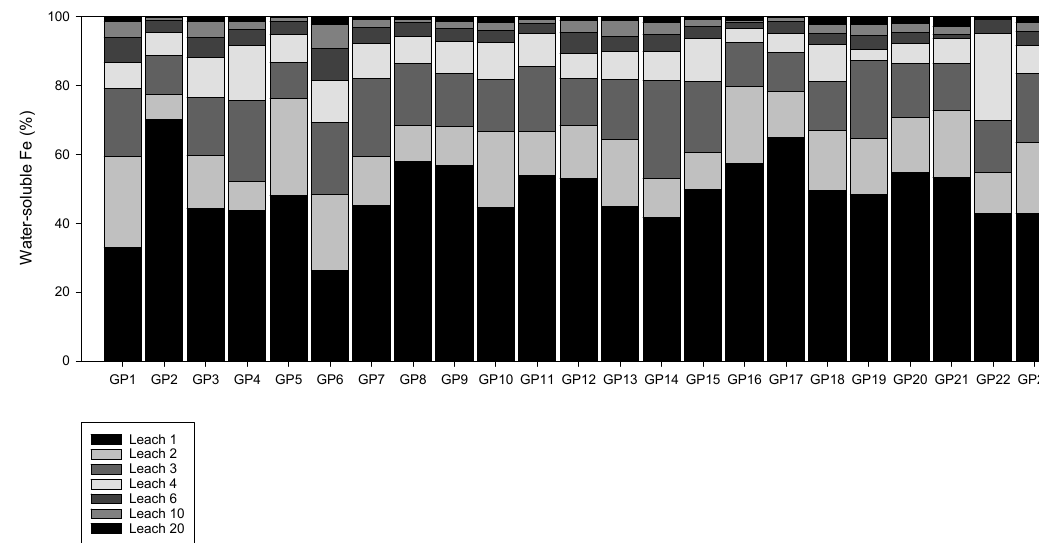
Figure 2. Fraction of water-soluble iron in sequential leaches of all PM 10 samples from the SAFIRED campaign. Details of samples GP1 to GP23 can be found in Table S1 in the